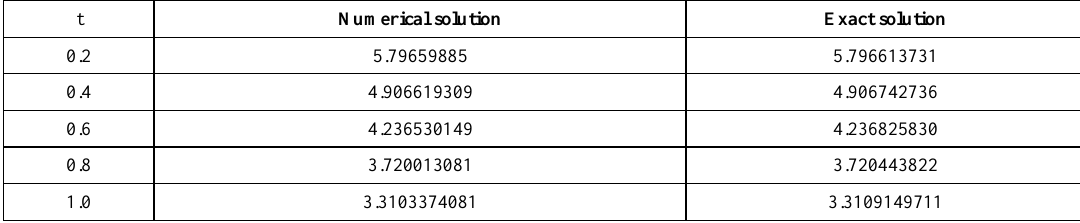
Table 2. Numerical comparison of the exact solution and the present